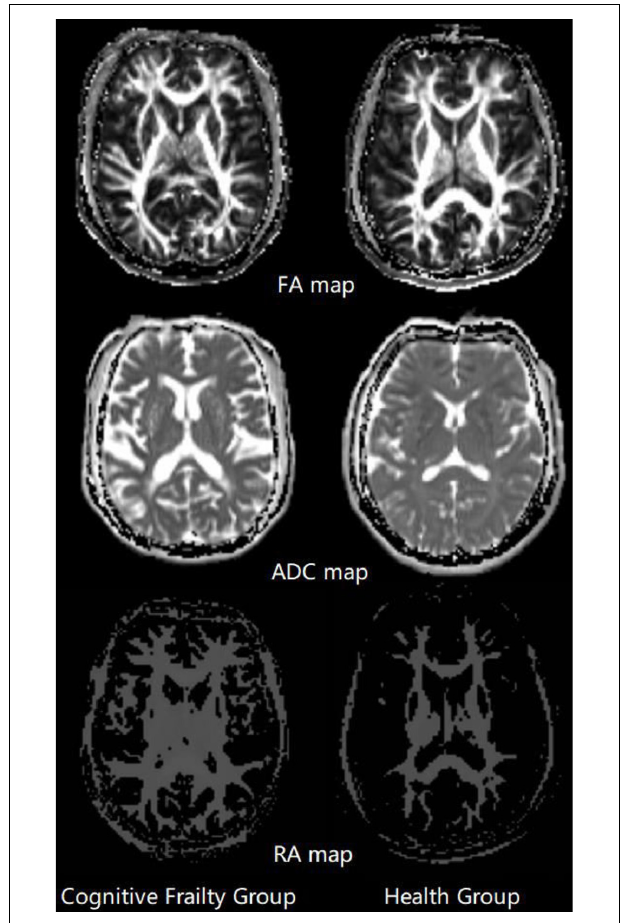
FIGURE 3 | Fractional anisotropy (FA), apparent diffusion coefficient (ADC), relative anisotropy (RA) map comparison between two groups. The mean values of FA, ADC and RA were computed within thalamus, caudate nucleus, globus pallidus and nucleus accumbens for individual